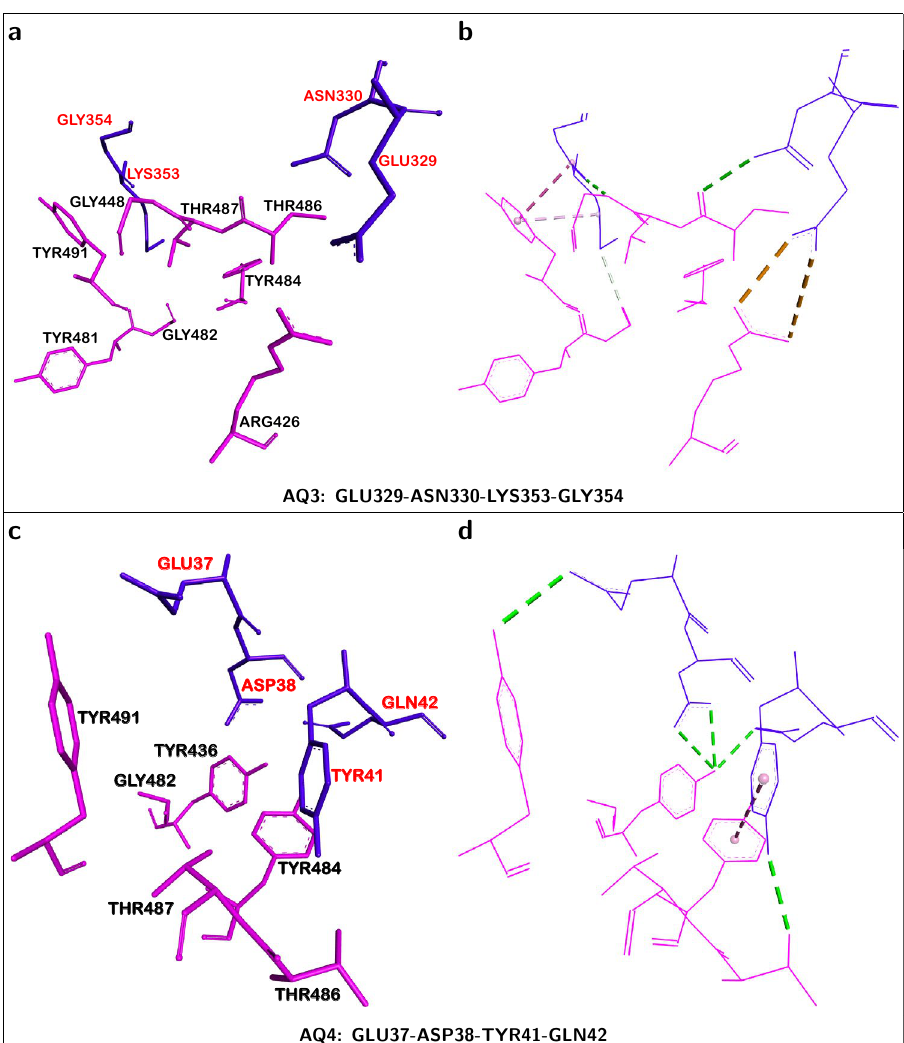
Figure 2. The two hACE2-centered fragments producing a net attractive interaction towards S-RBD. ACE2 quartet residues (shown in blue) and neighboring S-RBD residues (shown in pink) corresponding to the dominant attractive ACE2...S-RBD interactions. ACE2 is the structural reference. ( a, b ) Constituent residues and selected intermolecular interactions, respectively, of attractive AQ3 -centered fragment. ( c, d ) Constituent residues and selected intermolecular interactions, respectively, of attractive AQ4 -centered fragment. Dotted lines correspond to i) amid- π interactions in (b) and π - π interactions in (d) (dotted pink lines), ii) conventional (dotted green lines) and non-conventional (dotted white lines) hydrogen bonds and iii) electrostatic interactions (dotted yellow